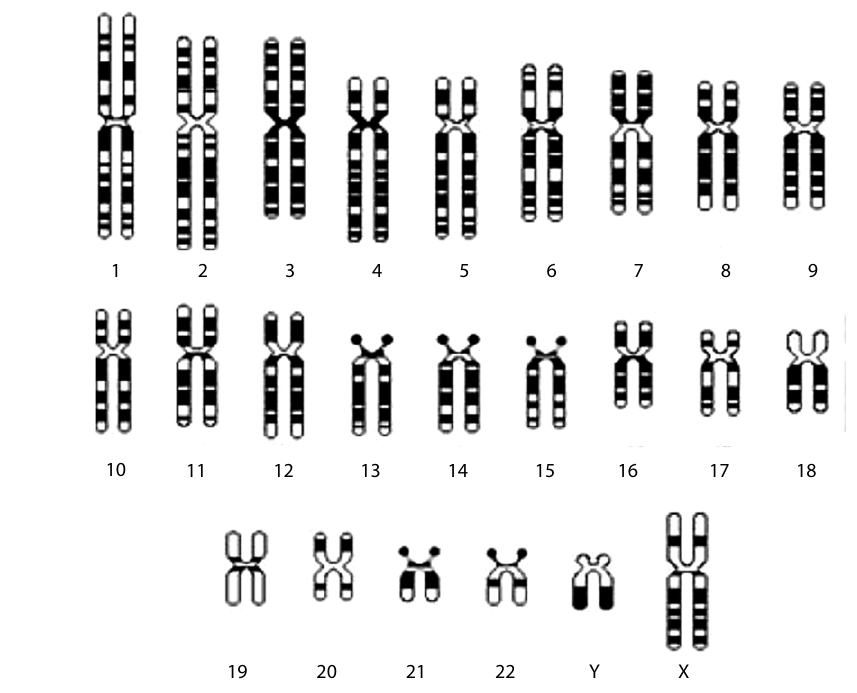
Figure 2. Diagrammatical representation of the human karyotype of haploid chromosome set with X and Y as the sex chromosome complement. The alternating light and dark bands are characteristic of each chromosome in standard G-banding karyotype, and they represent euchromatic and heterochromatic regions, respectively. Genomic DNA contains coding as well as non-coding regions. The non-coding regions are involved in DNA folding, chromosome formation, chromatin organization within the nucleus, regulation of transcription and more [11–14]. The coding regions are responsible for the transcription of RNA molecules and ultimately protein